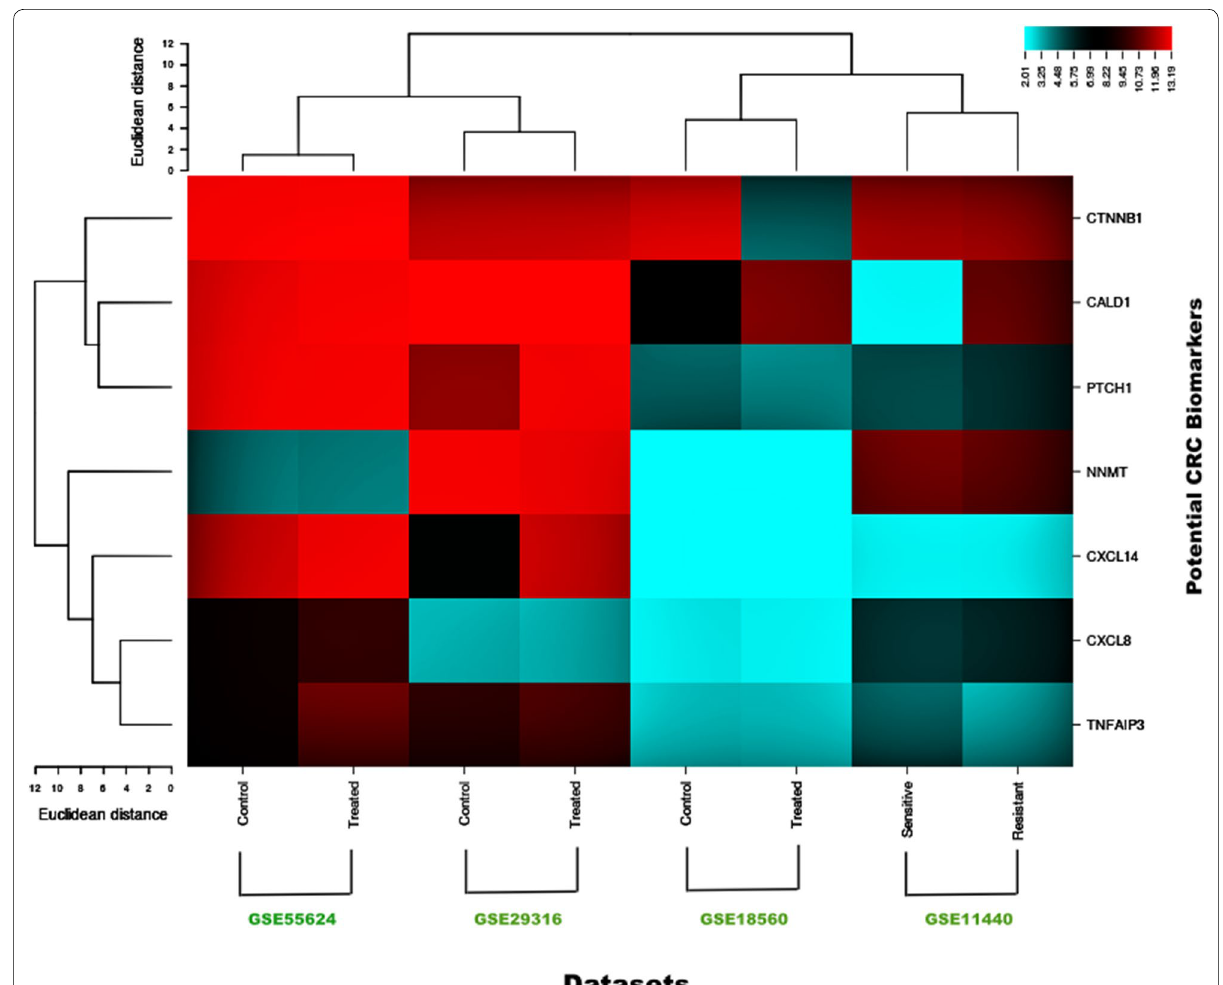
Fig. 3 Cluster analysis of 7 colorectal related DEGs. Blue corresponds to a small distance and Red to a large distance. Lines indicate the boundaries of the clusters in the level of the